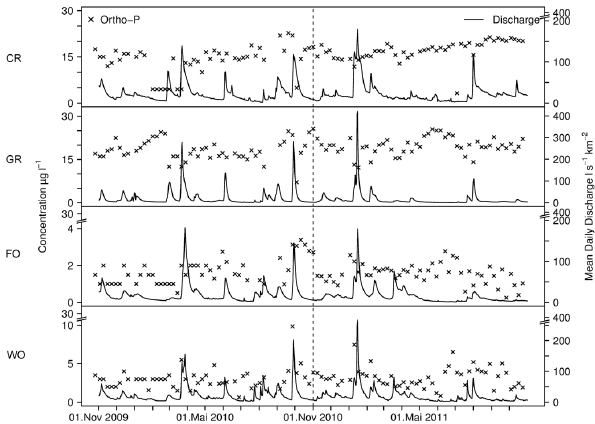
Fig. 4. Time series of measured Ortho-P concentrations and dis- charge at the catchments representing the different land-use types “Crops” (CR), “Grassland” (GR), and “Forest” (FO) and at the “Wa- tershed Outlet” (WO). Scales for concentration and daily discharge vary with the catchments due to different magnitudes.